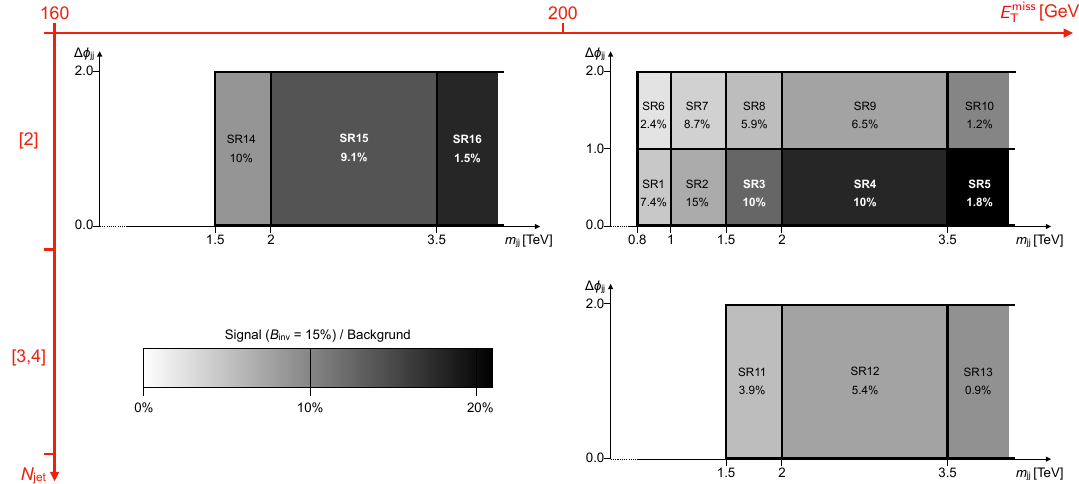
Figure 2. Schematic view of the 16 bins in the signal region. The shading indicates the signal- to-background ratio, assuming a branching fraction of the Higgs boson to invisible particles of B inv = 0 . 15 . The percentage gives the approximate contribution of signal from invisibly decaying Higgs bosons to each of the bins relative to the total signal yield in the inclusive